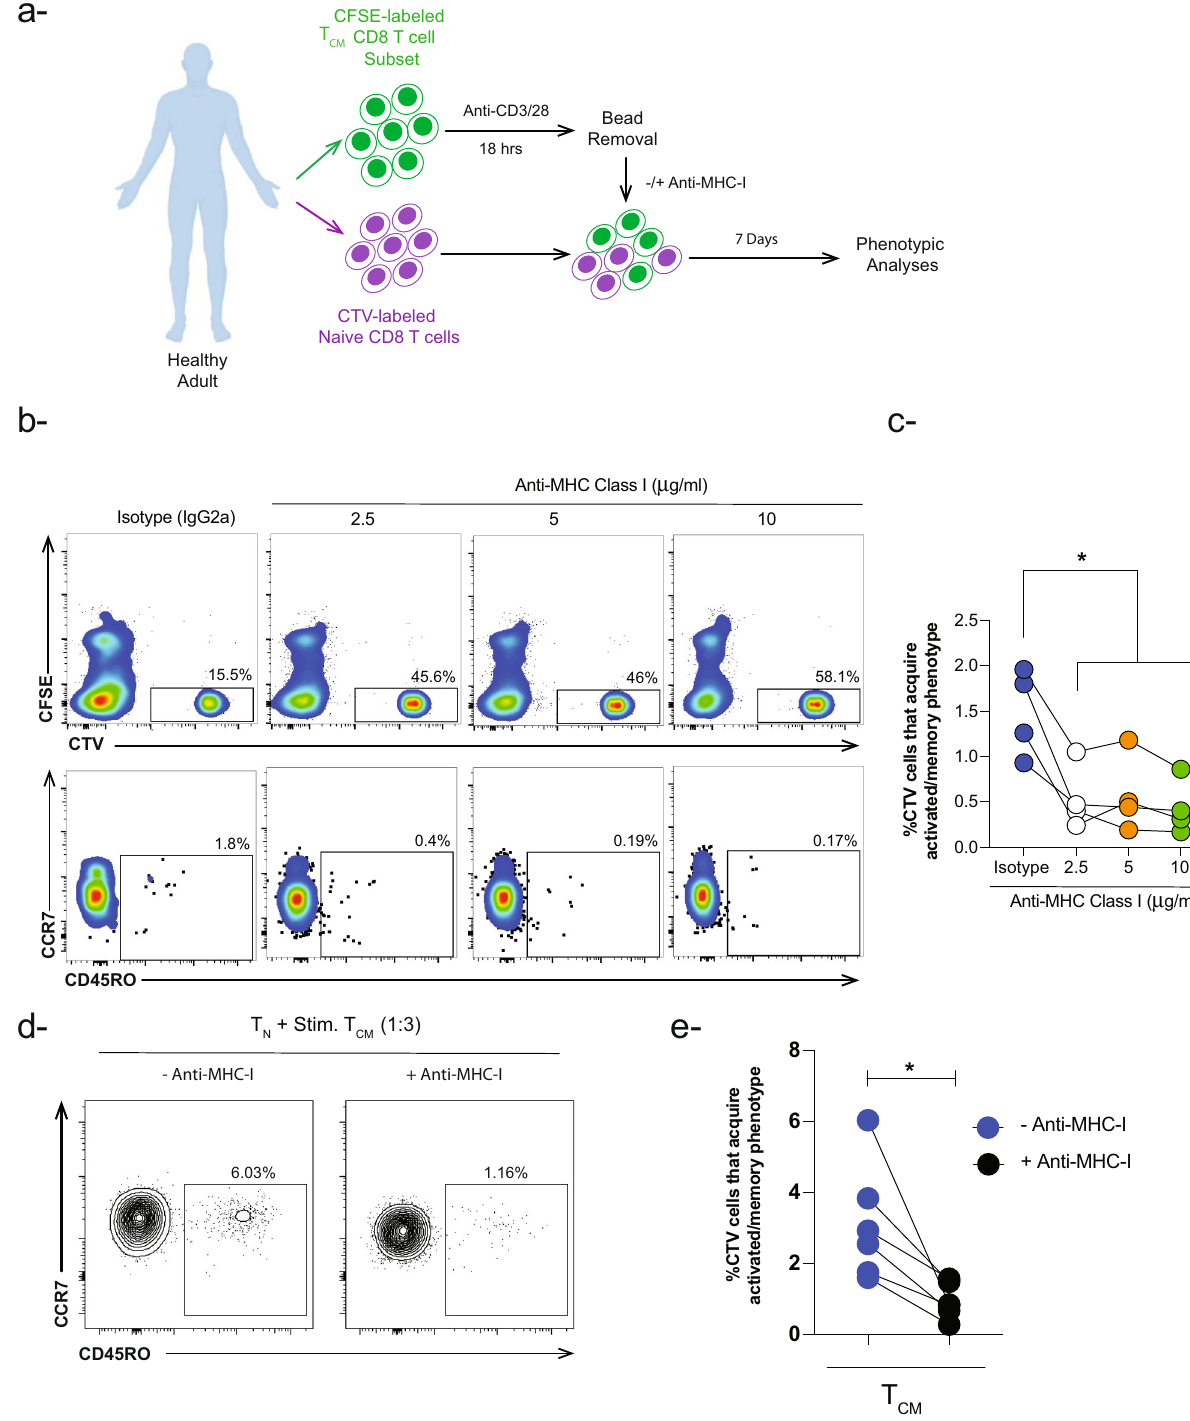
Fig. 5 Activated/memory phenotype is acquired by naïve CD8 T cells in MHC class I dependent manner. a Schematic view of the experimental approach shows that naïve and memory T CM CD8 T cells were sorted from healthy adults then labeled with CTV and CFSE respectively. CFSE-labeled T CM cells were stimulated with anti-CD3/CD28 beads (1:1 ratio). After overnight stimulation, beads were removed by plate magnet followed by incubation with CTV- labeled naïve CD8 T cells at ratio 1:1 and 3:1 ratio (memory:naïve) in the presence of different concentrations of anti-MHC class I antibody. Isotype antibody IgG2a was used as a control (2.5 μ g/ml). b Representative fl ow cytometry plots and c Column graph (individual values) tracking the effect of anti-MHC-I antibody at different concentrations (2.5, 5, 10 μ g/ml) on the acquisition of activated/memory phenotype by naïve CD8 T cells compared to isotype control. Ordinary one-way ANOVA Bonferroni multiple comparison test was used *P < 0.05 ( n = 4). d Representative fl ow cytometry contour plots and e- Paired analysis showing the incidence of CTV-labeled naïve CD8 T cells that acquired a memory phenotype in the presence of stimulated T CM CD8 T cells (memory:naïve — 3:1 ratio) with (black circle) or without (blue circle) anti-MHC Class I antibody 5 μ g/ml. Wilcoxon test (paired nonparametric t test) was used *P < 0.05 ( n =